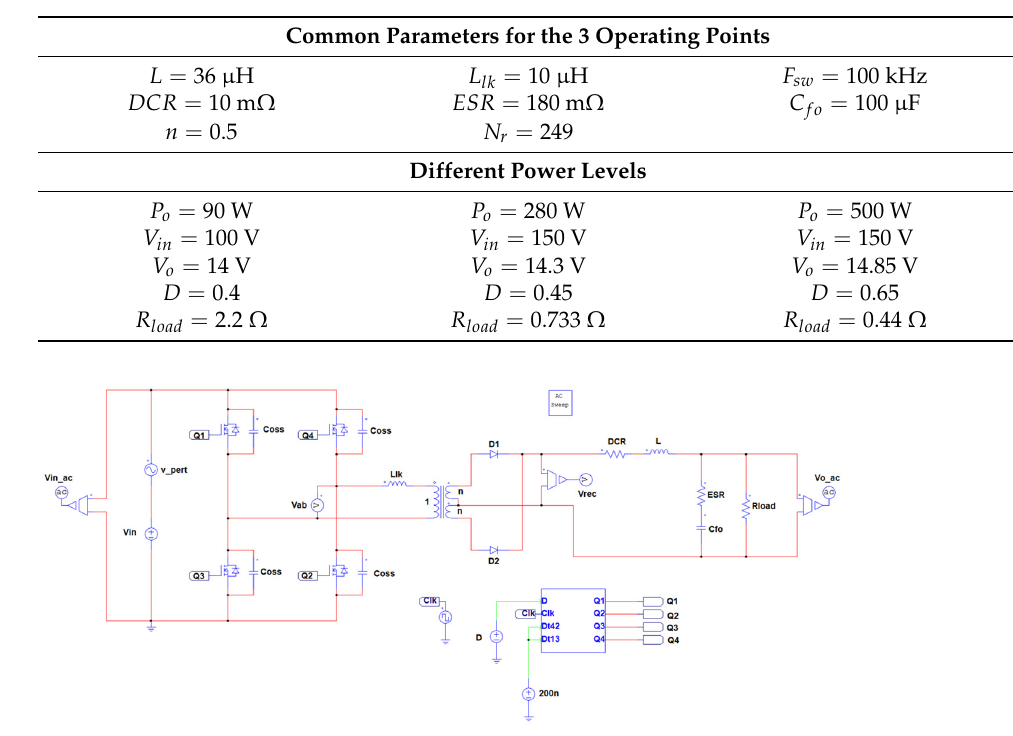
Table 3. Parameters to obtain the frequency response at different power levels.